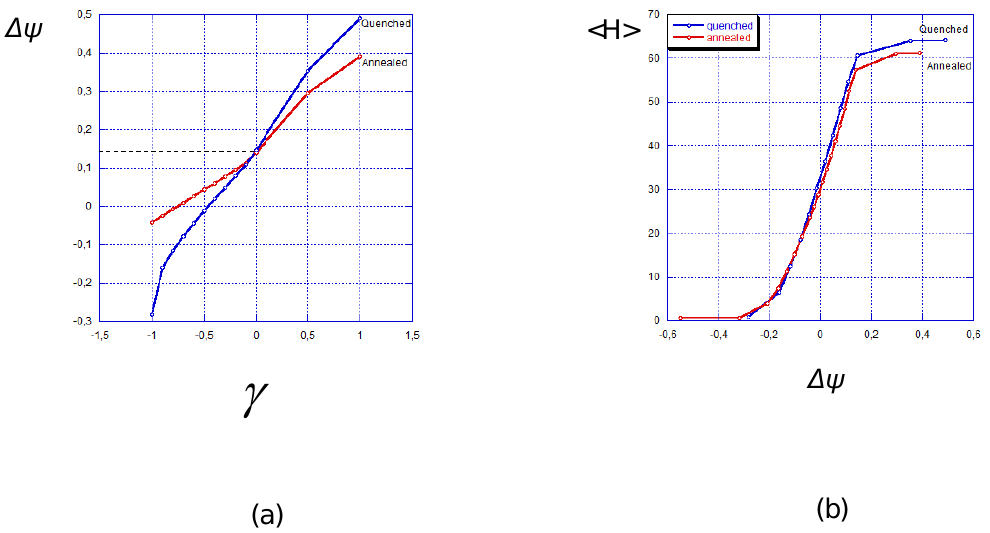
Figure 8. Surface potential ∆ ψ vs. reduced surface charge γ ( a ) and average thickness (the first moment of the polymer density) vs. surface potential in strong (blue curves) and weak (red curves) polyelectrolyte brushes ( b ). The average fraction of charged monomer units in strong and weak polyelectrolyte brushes at zero surface charge is the same and corresponds to α = (cid:104) α (cid:105) = 0.5. Other parameters: N = 300, a 2 / s = 0.001, salt concentration c s a 3 = 10 − 5